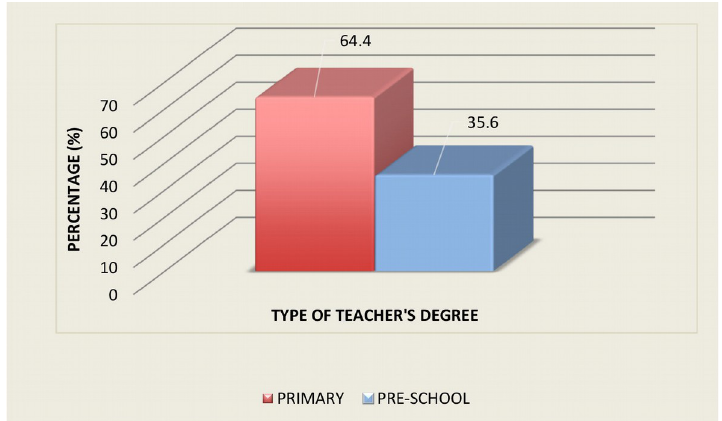
Figure 3. Percentage of subjects with content on the didactic use of cinema according to the Teacher’s